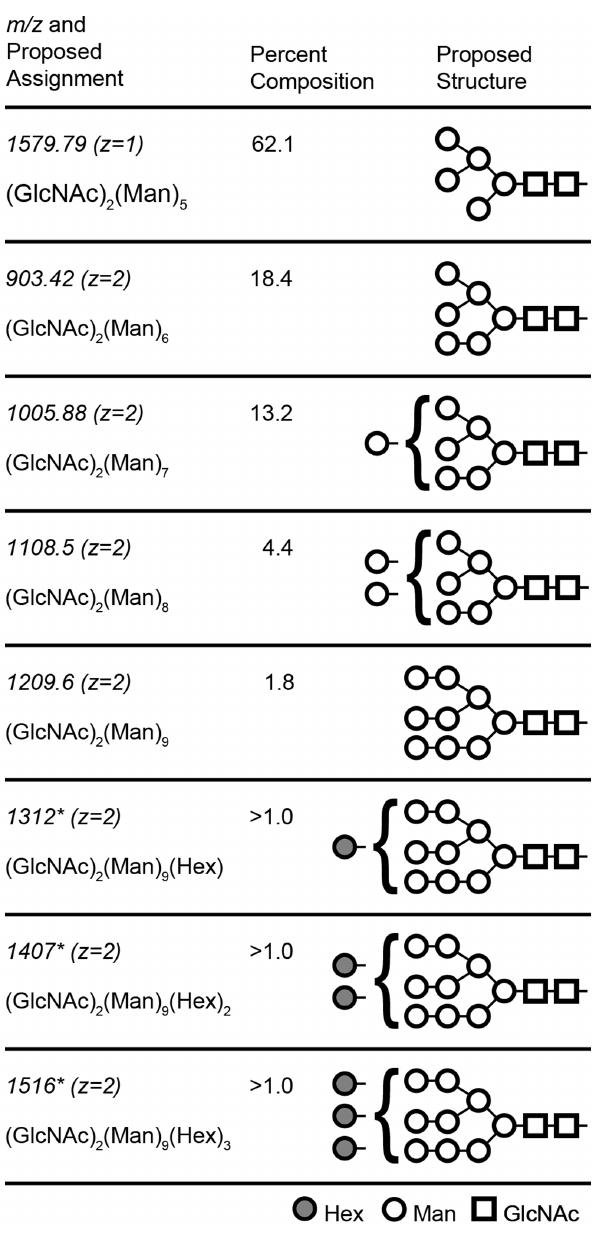
Figure 2. Permethyated glycans released from glycosylated rHA Schizochytrium cell-free supernatant. Given weights include addition of sodium, and account for permethylation. *Observed during total ion mapping (TIM), m/z value refers to the 2 mass unit window in which the noted MS/MS loss was observed. Hexose (Hex), mannose (Man), and N-acetylglucosamine (GlcNAc) residues are represented by gray circles, open circles, and open squares, respectively.